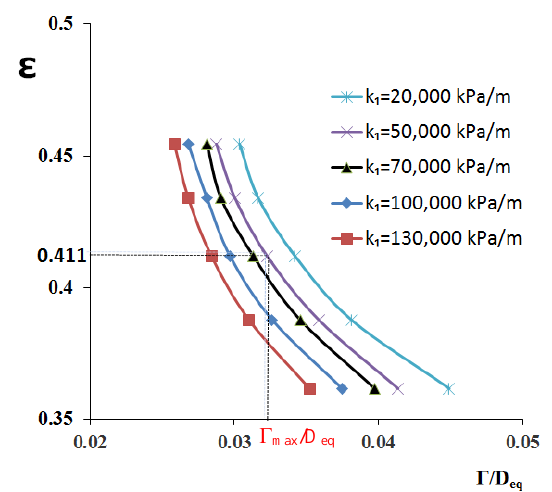
Figure 11. Relationship between the embedded ratio of pile and normalized pile-head displacement.